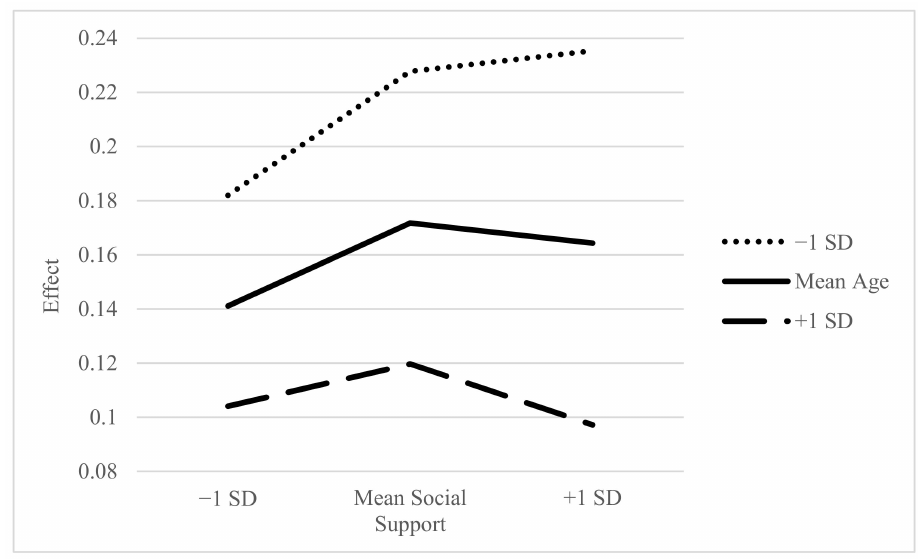
Figure 3. Conditional Indirect Effects of Distress on PTSS as Moderated by Age and Social Support (Mediated by Symptom